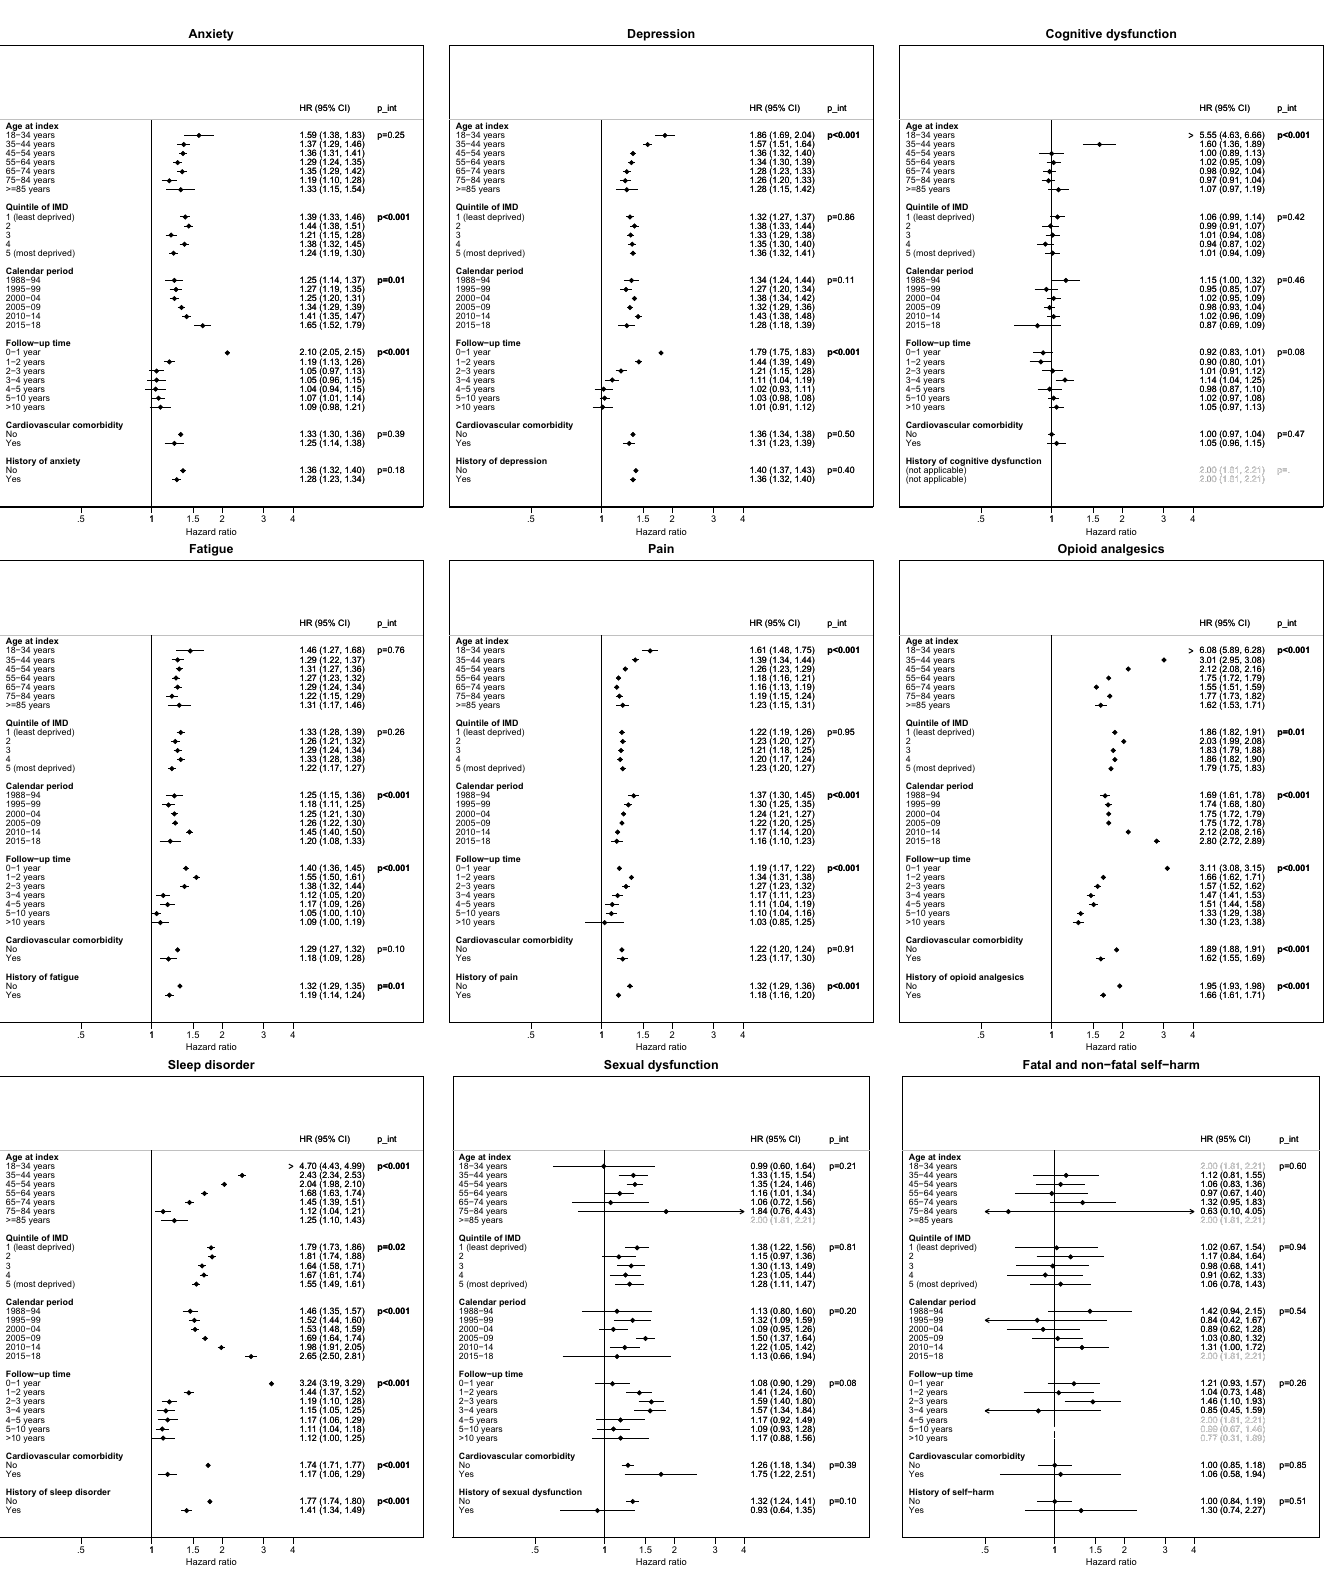
Fig 3. Forest plots of the association between breast cancer survivorship and adverse mental health outcomes, fatigue, and pain, stratified by potential effect modifiers. 95% CI, 95% confidence interval; HR, hazard ratio; IMD, Index of Multiple Deprivation.